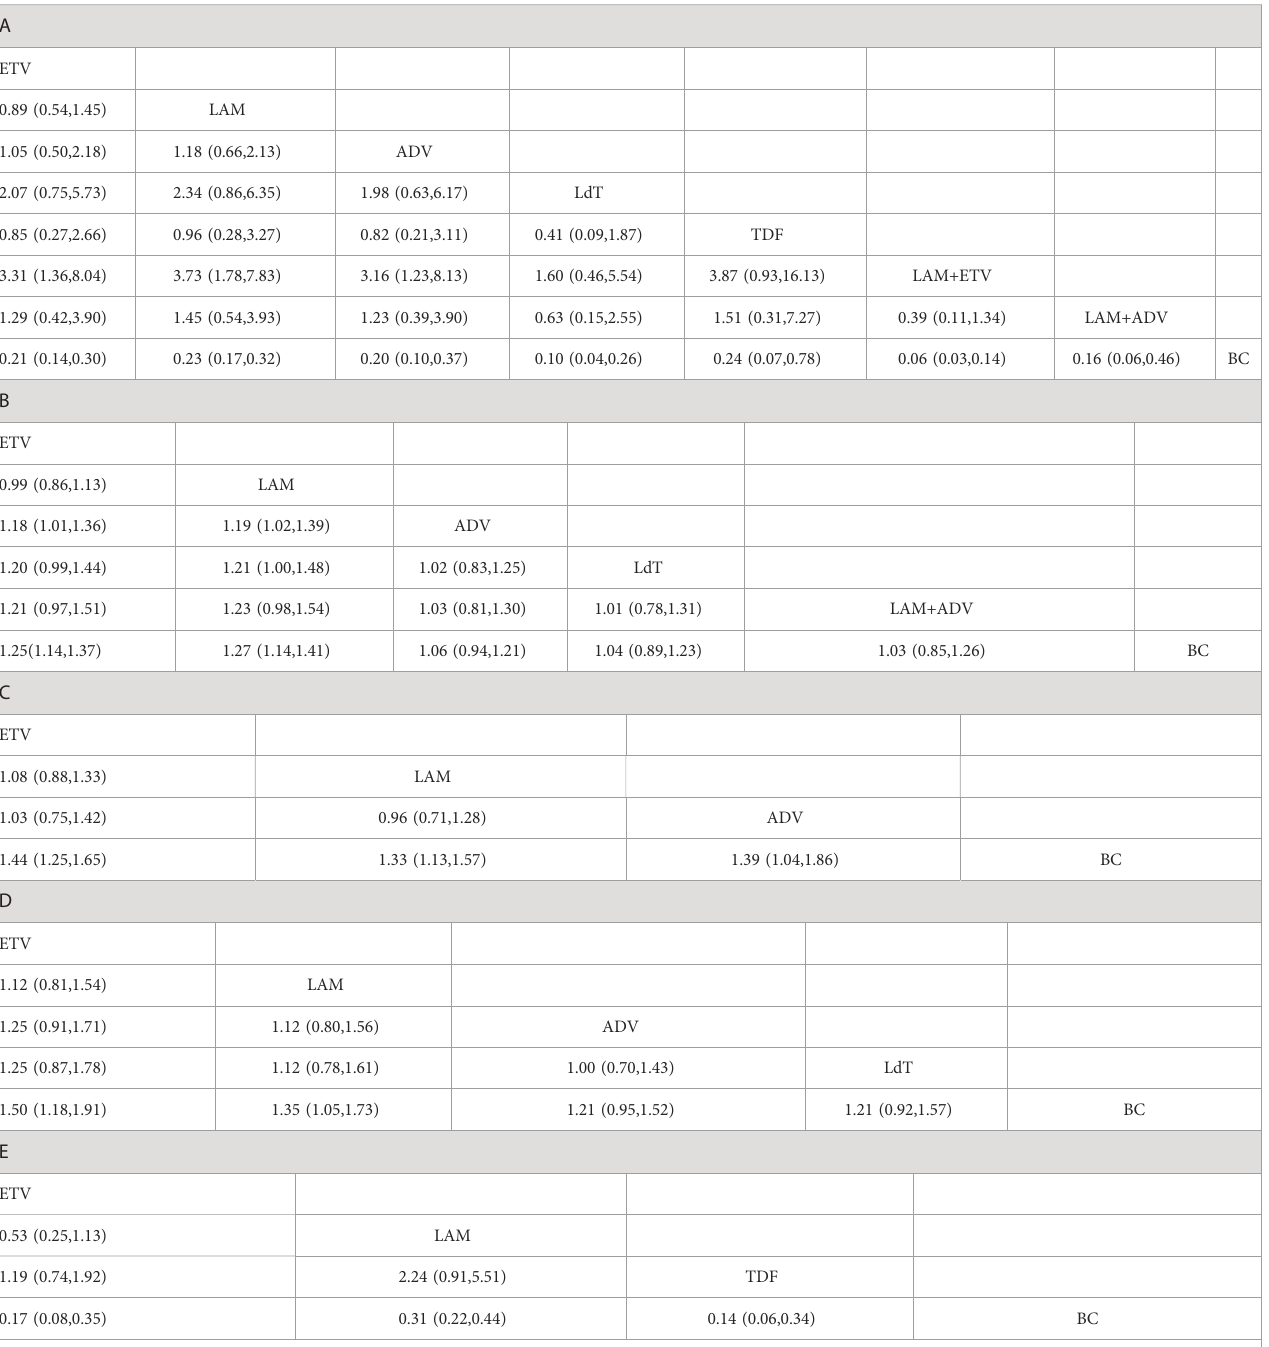
TABLE 1 Pairwise comparison for each outcome indicator according to the network